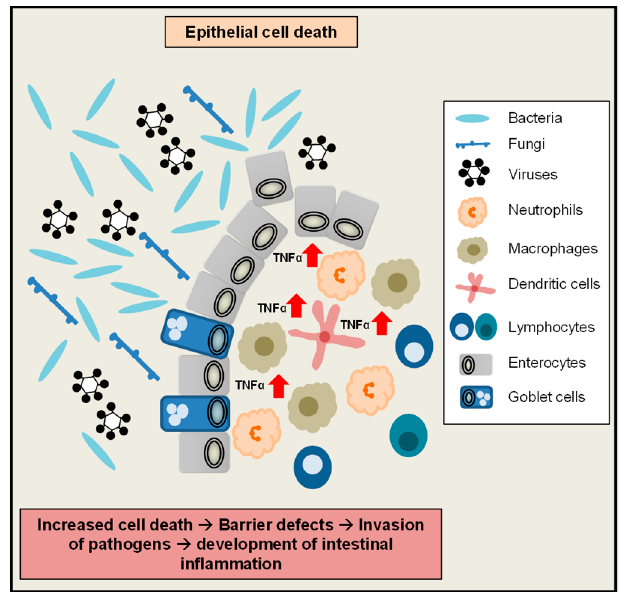
Figure 2. Regulation of epithelial cell death in the intestine by TNF α . Increased TNF α levels can trigger epithelial cell death in the intestine, which potentially leads to barrier defects and invasion of harmful pathogens. Altogether this might trigger or perpetuate the development of intestinal inflammation.